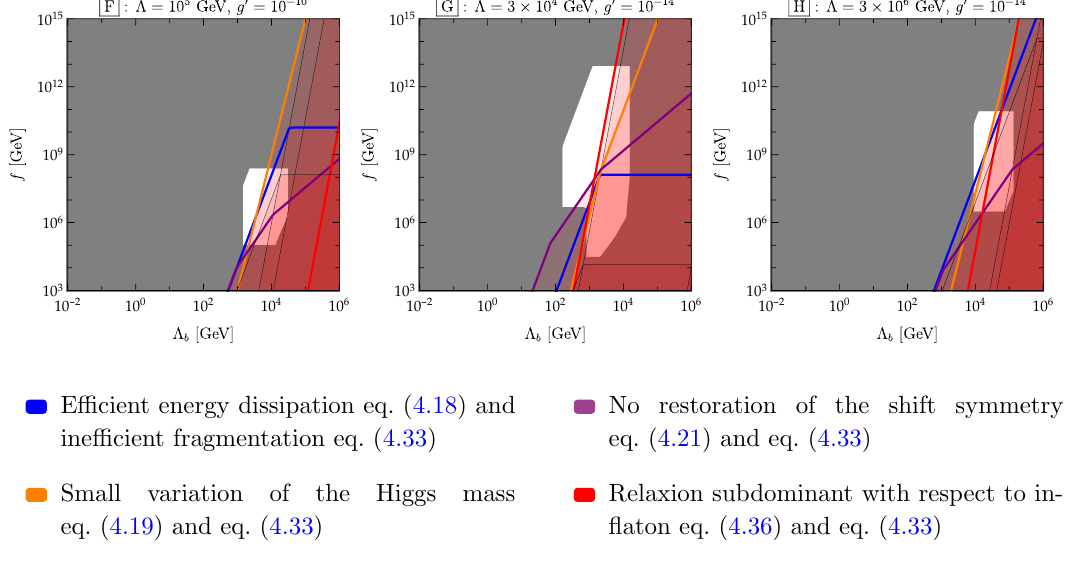
Figure 33 . Same as (cid:12)gure 32 (EW gauge boson production during in(cid:13)ation). The gray region is the envelope of the contours shown in (cid:12)gure 33. The coloured contours are obtained by imposing that fragmentation is not e(cid:14)cient (see section 4 in the main text for further explanation)